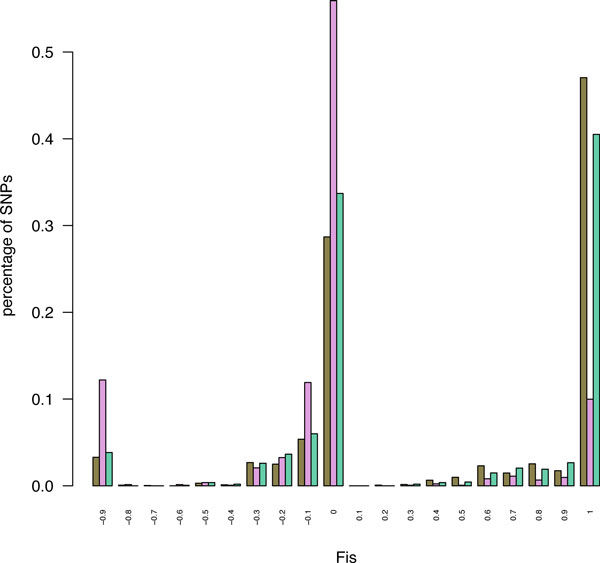
Distribution of Fis values of: diploid SNPs (brown), de novo SNPs (pink) and HomeoSplitter SNPs (green). Fis values were calculated as the heterozygosity deficit relative to panmixia. Allelic frequencies were estimated from the called genotypes with high confidence values (see text). Negative Fis values suggest fixed divergence between homeologous/paralogous copies. Fis around 0 indicate possible mixture of homeology and intra genome polymorphism. Fis values close to 1 sign a priori intra genome polymorphic sites. See Figure 1 for the pipeline leading to the detection of these three SNP sets